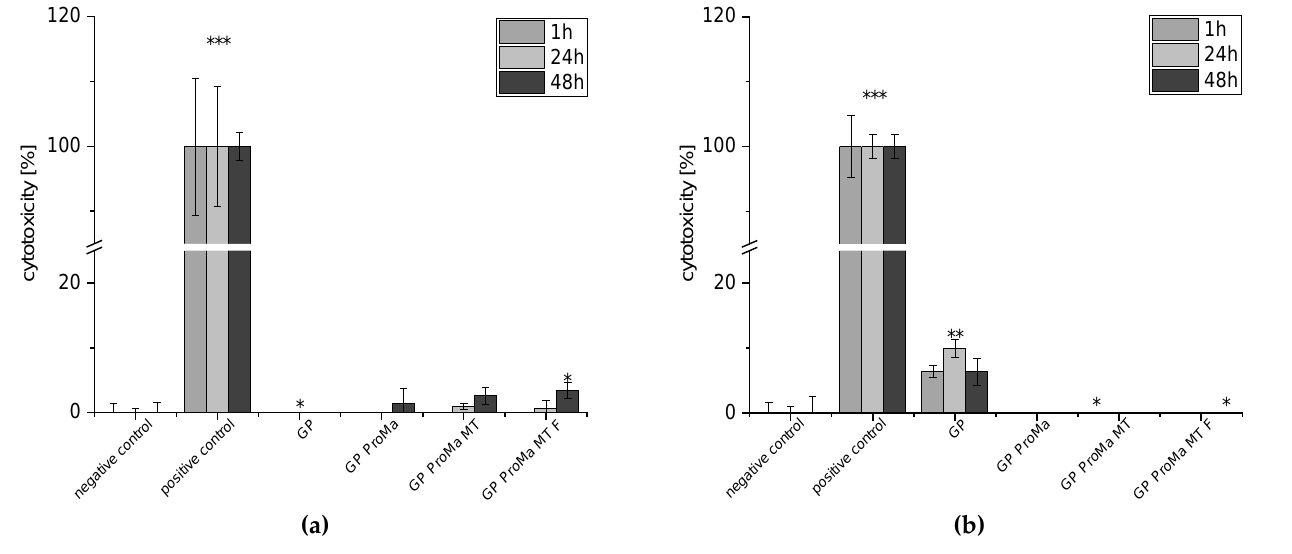
Figure 11. ( a ) Cytotoxicity [%] of the HaCaT cells exposed to the sample extracts in DMEM for 1 h, 24 h, 48 h; ( b ) cell count [%] of the HaCaT cells exposed to the sample extracts in defined sweat solution for 1 h, 24 h, 48 h. Asterisks indicate significant deviations from the negative control (* p < 0.05; ** p < 0.01; *** p < 0.001). The cell count [%] indicates the anti-proliferative impact of GP ProMa. In compar- ison, GP ProMa MT did not show an anti-proliferative effect, which indicates that